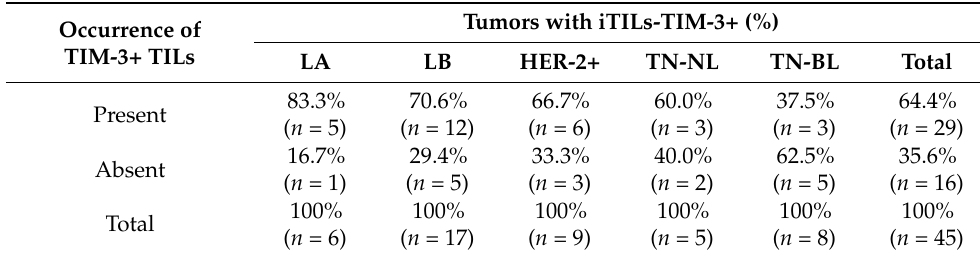
Table 3. Percentages (%) and frequencies ( n ) of tumors with TIM-3+ expression in intra-tumoral TILs (iTILs-TIM-3+) among the 45 FMC stratified according to their molecular subtype (luminal A (LA), luminal B (LB), HER-2+, triple-negative normal-like (TN-NL), and triple-negative basal-like